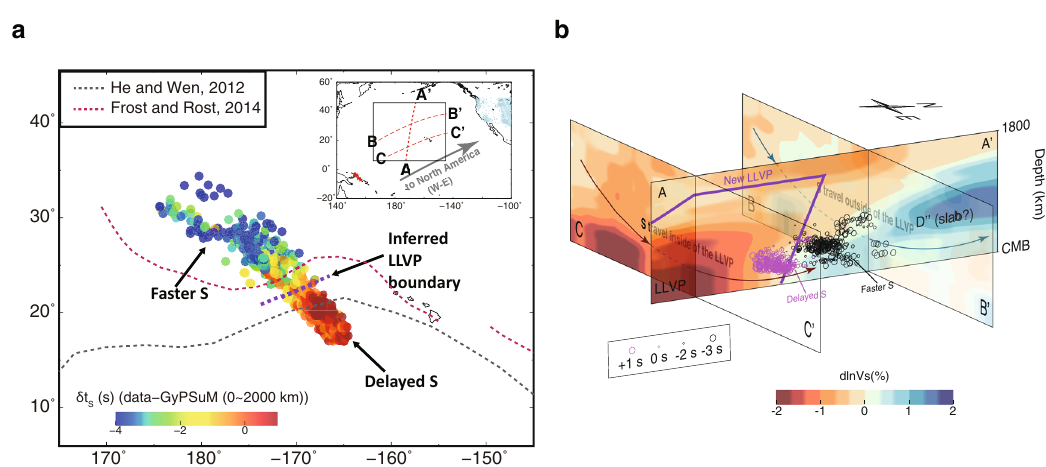
Fig. 4 S travel time anomaly from West-East pro fi le. a Enlarged view marked with black box in inset showing S travel time residuals for events in Solomon Islands (red stars in inset) recorded in North America (light blue triangles in inset) on the West-East pro fi le after correction to a common station MLAC relative to the GyPSuM model 5 at a depth of 0 − 2000 km. Results are plotted at their turning points. Note the sudden change of travel time residuals across the inferred northern boundary of the Paci fi c Large Low-Velocity Province (LLVP) (purple dashed line). The grey and red dashed lines are LLVP boundaries from He and Wen 24 and Frost and Rost 35 , respectively. b S travel time residuals on the West-East pro fi le (BB ’ and CC ’ ) in a projected on the North-South pro fi le (AA ’ ) as color-coded circles with size proportional to residual magnitude at their turning depth. The depth cross-sections are from the GyPSuM model. BB ’ and CC ’ pro fi les are consistent with S wave traveling outside (faster) and inside (delayed) of the LLVP, respectively. The purple line outlines our inferred LLVP surface by separating delayed (magenta) and faster (black) S travel time